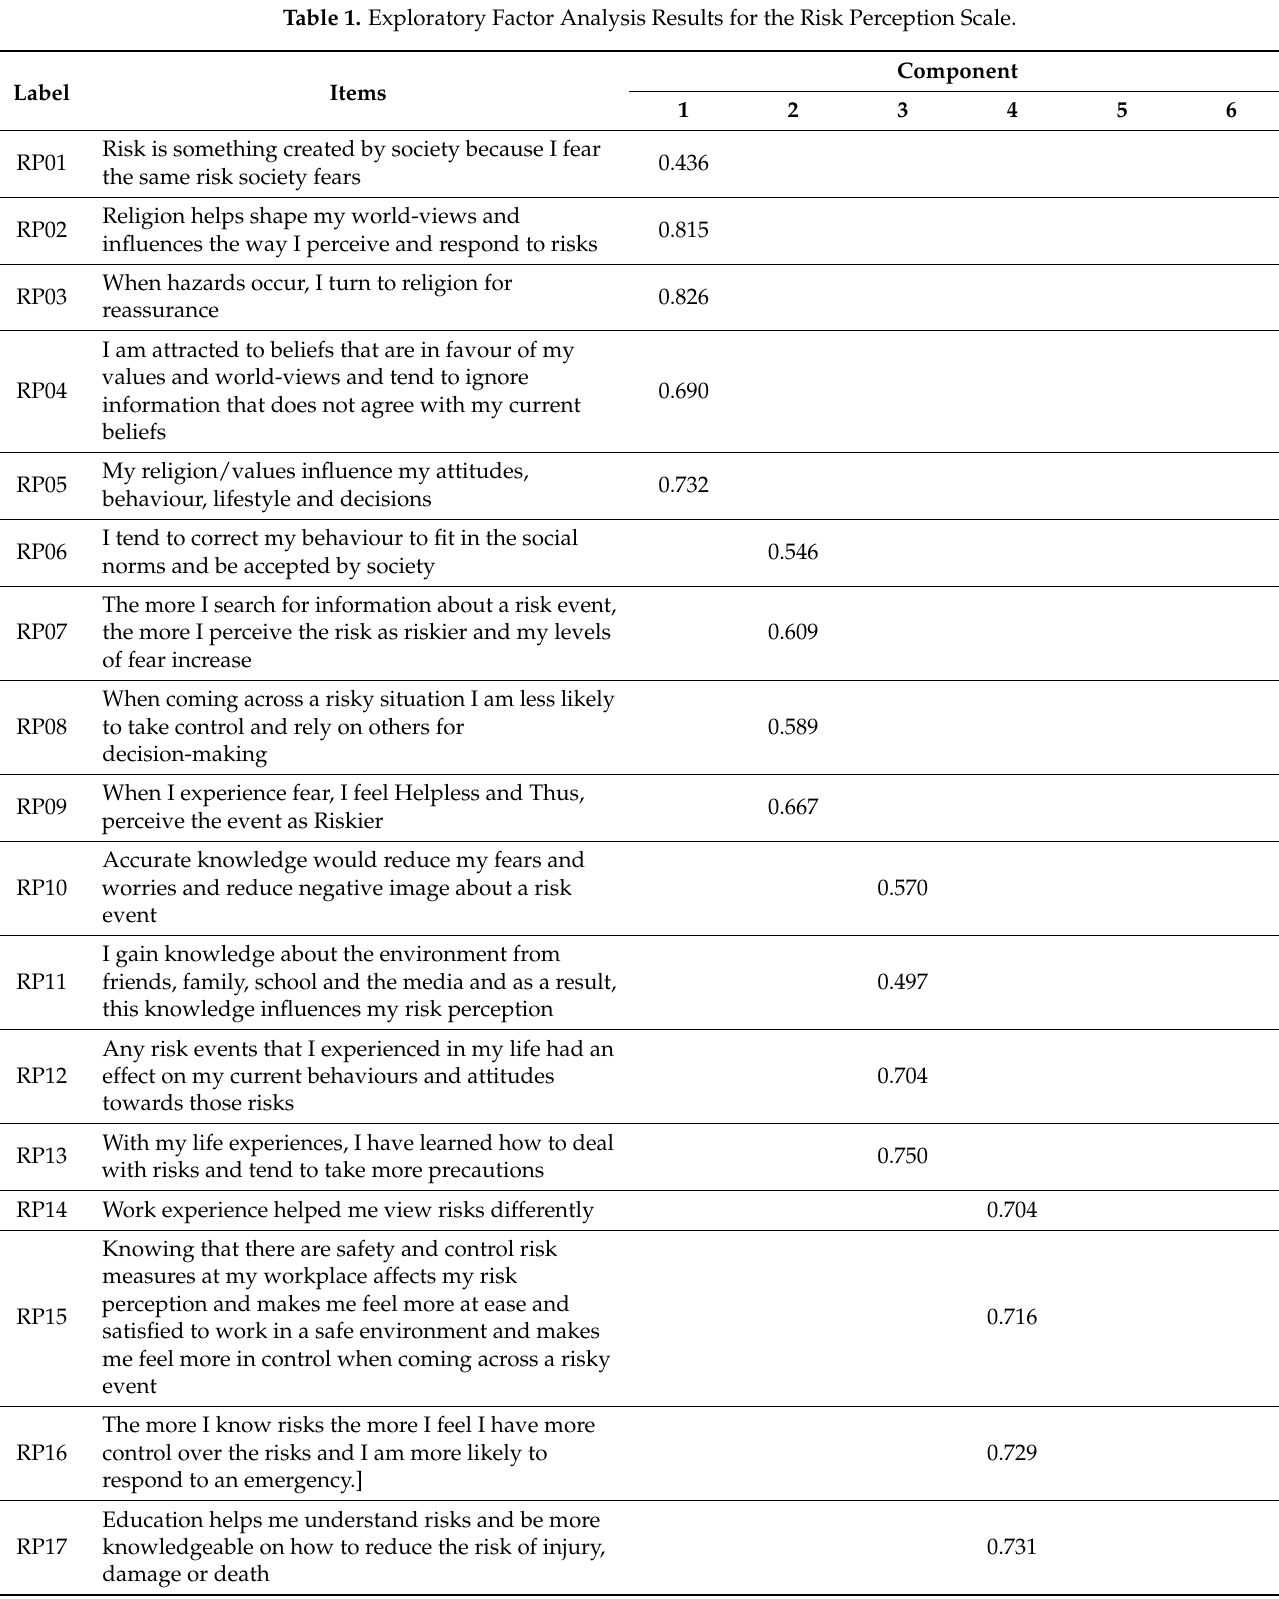
Table 1. Exploratory Factor Analysis Results for the Risk Perception